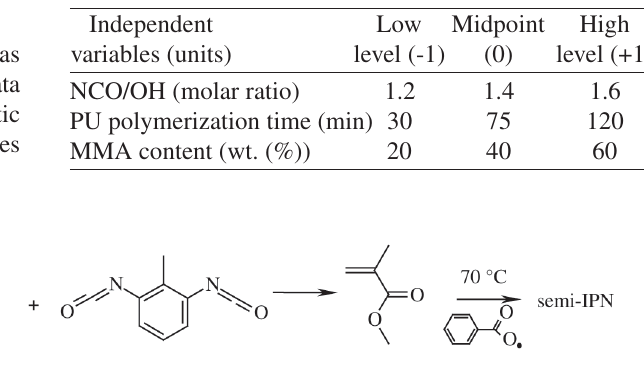
Table 1. Factor levels of the independent variables semi-IPN